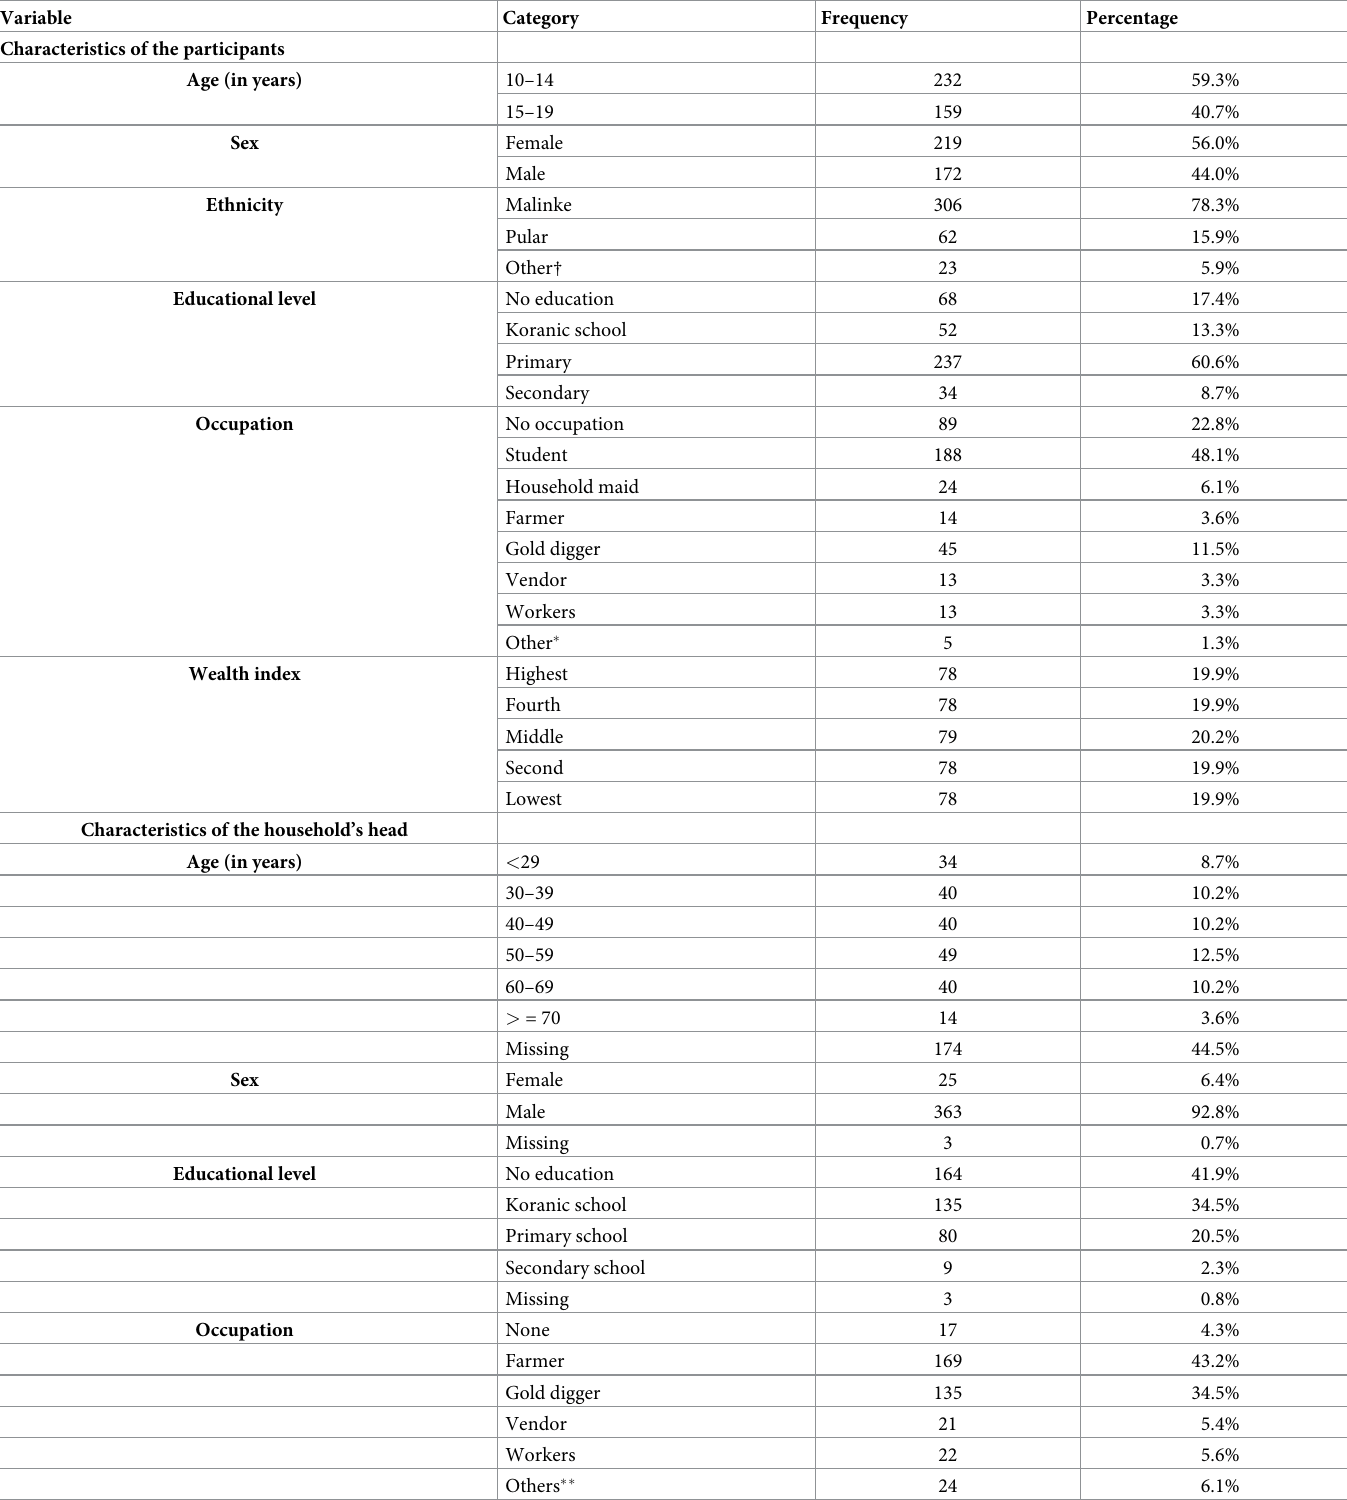
Table 1. Socio-demographic characteristics of the study